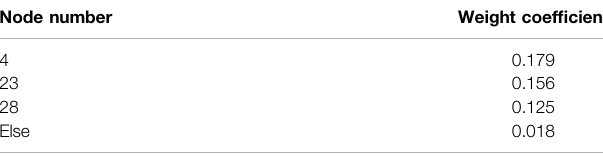
TABLE 1 | Weight coef fi cient of each node. Node number